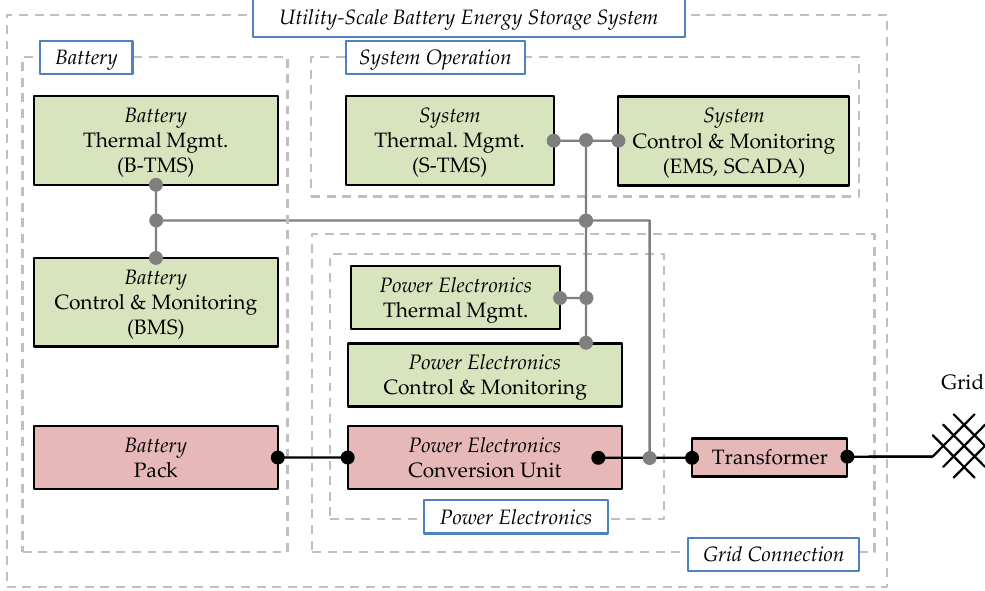
Figure 3. Overview to functional blocks of an utility-scale battery energy storage system. Grey linesindicate auxiliary power supply, black lines indicate main energy storage power flow. System topology information based on previous work